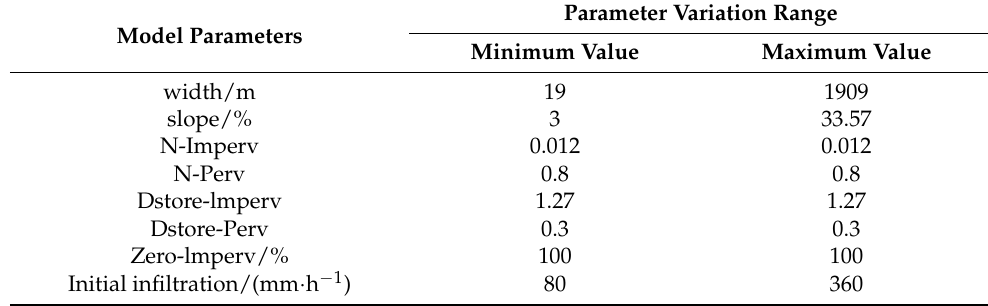
Table 1. Regional rainfall runoff model parameter